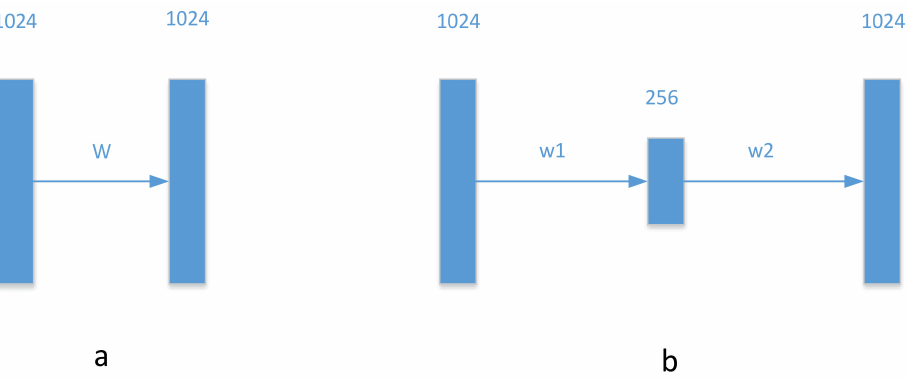
Figure 5. SVD transformation in the fully connected layer. ( a ) General fully connected layer. ( b ) Fully connected layer after